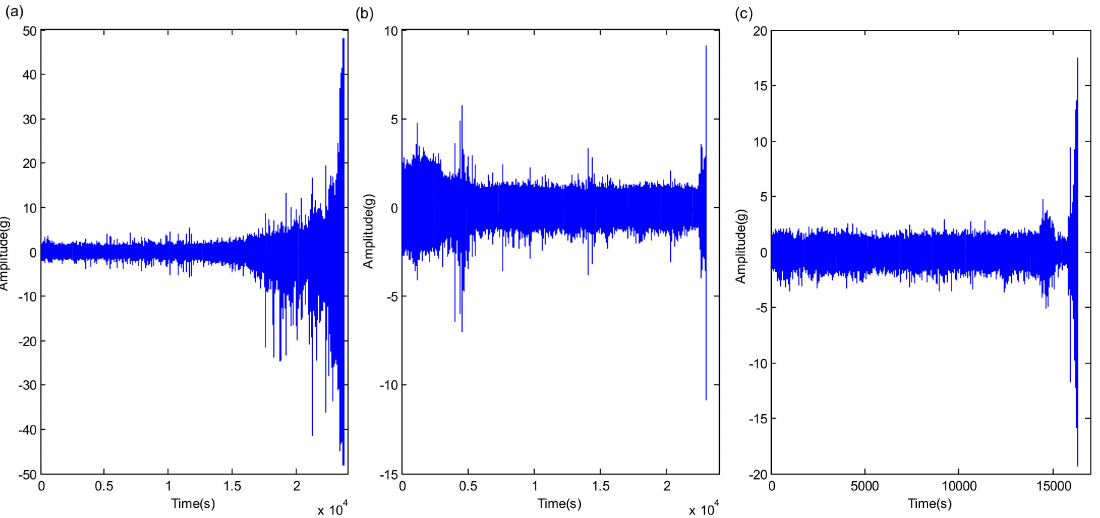
Figure 11. The temporal waveforms of whole-life signals in PHM 2012 dataset. ( a ) bearing1_3; ( b ) bearing2_5; ( c )